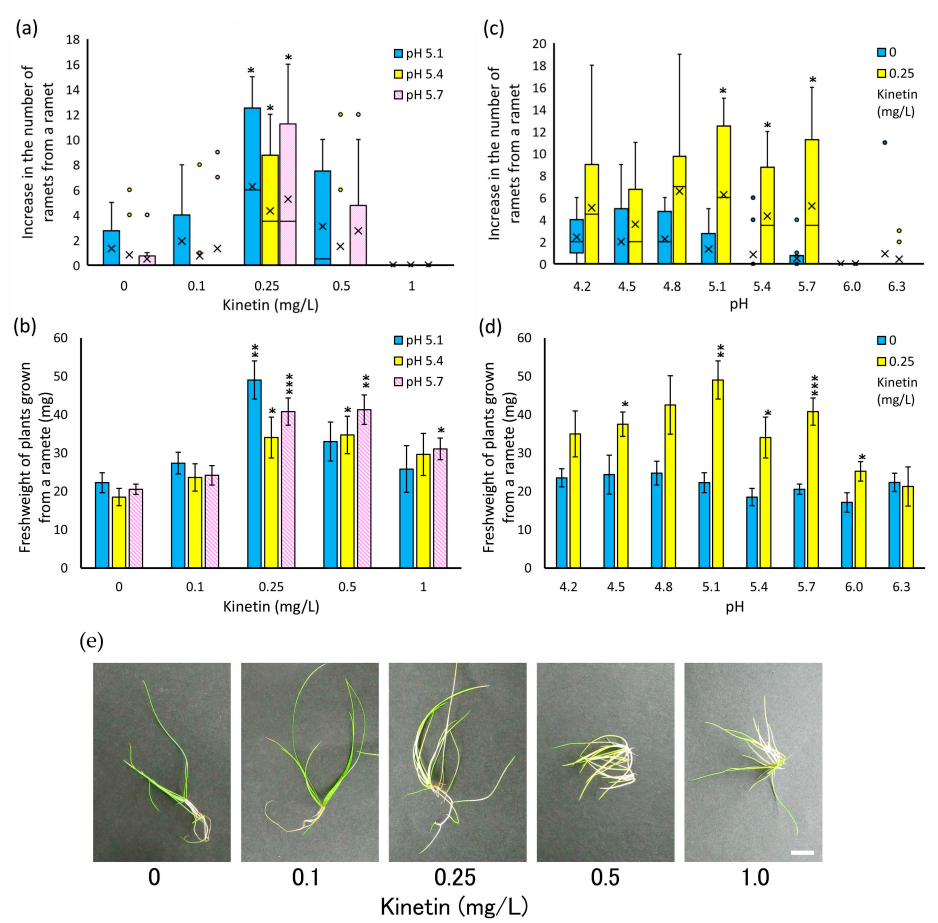
Figure 4. Effects of various concentrations of kinetin and various pH ranges on the growth of ramets ( a , b , c , d ). The number of newly formed ramets from a young isolated ramet (box plot, X indicates average, n = 12) ( a , c ) and the weight of newly formed plants from a young isolated ramet (bar graph, n = 12, Bar: SE) ( b , d ) in 4 weeks at various concentrations of kinetin (0, 0.1, 0.25, 0.5, 1 mg/L) and three pH values (5.1, 5.4, 5.7) ( a , b ) or in the absence or presence of kinetin (0.25 mg/L) and various pH values (4.2 to 6.3) ( c , d ). Asterisks indicate significant differences from the value of 0 mg/L kinetin under the same pH (two-sided Wilcoxon rank sum test; ( a , c ) two-sided Welch t -test; ( b , d ) * p < 0.05; ** p < 0.01; *** p < 0.001). ( e ) Plants grown from a young, isolated ramet cultured for 4 weeks in various concentrations of kinetin at pH 5.7. These results were representatives of two experiments.